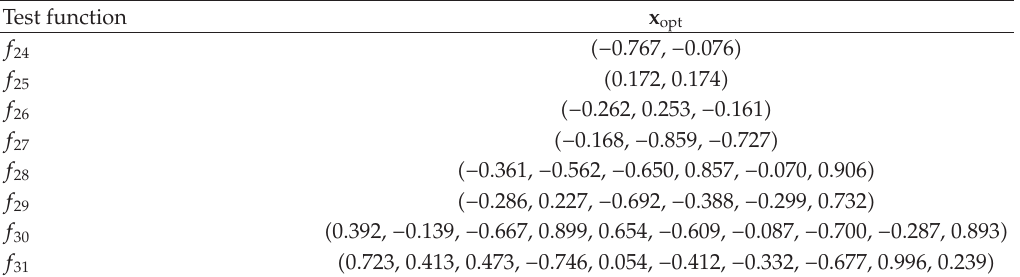
Table 17: Optimum locations of the used GKLS